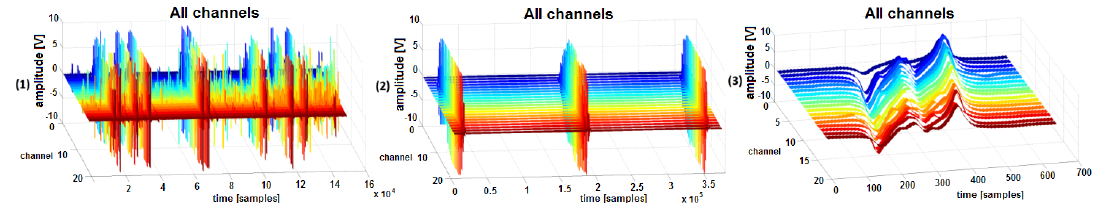
Figure 8. The magnetic field variations recorded for a belt section with damages and splices ( 1 ); a belt section with only splices ( 2 ); a single splice ( 3 ).